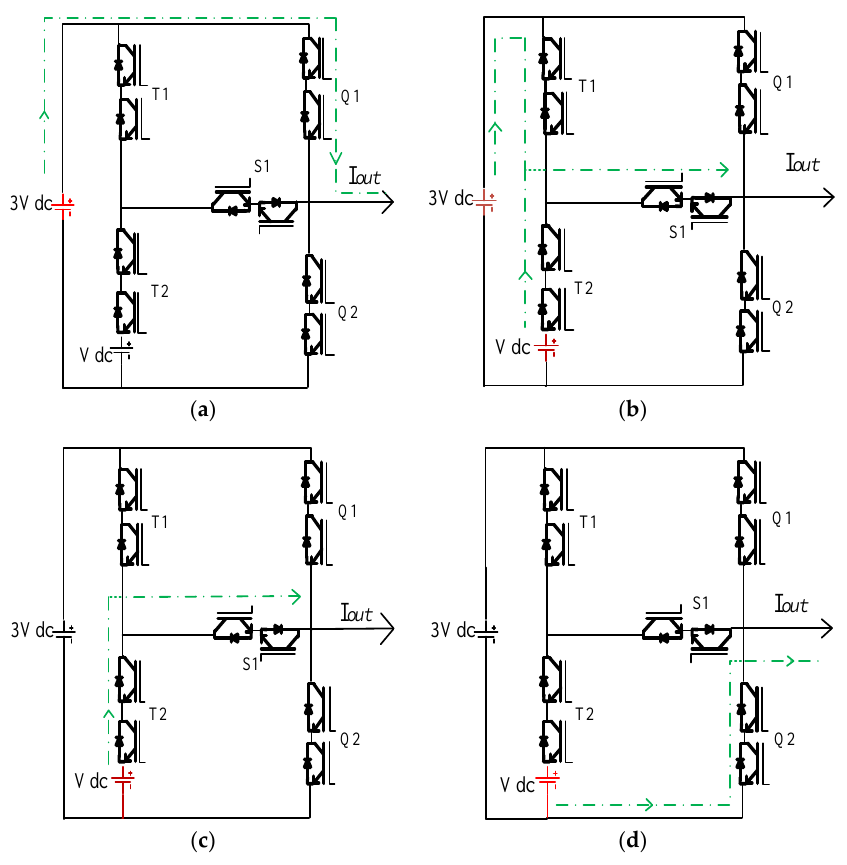
Figure 2. Current commutation during switching transition for positive output current to generate: ( a ) 3 Vdc ; ( b ) 2 Vdc ; ( c ) 1 Vdc ; and ( d ) 0 Vdc .